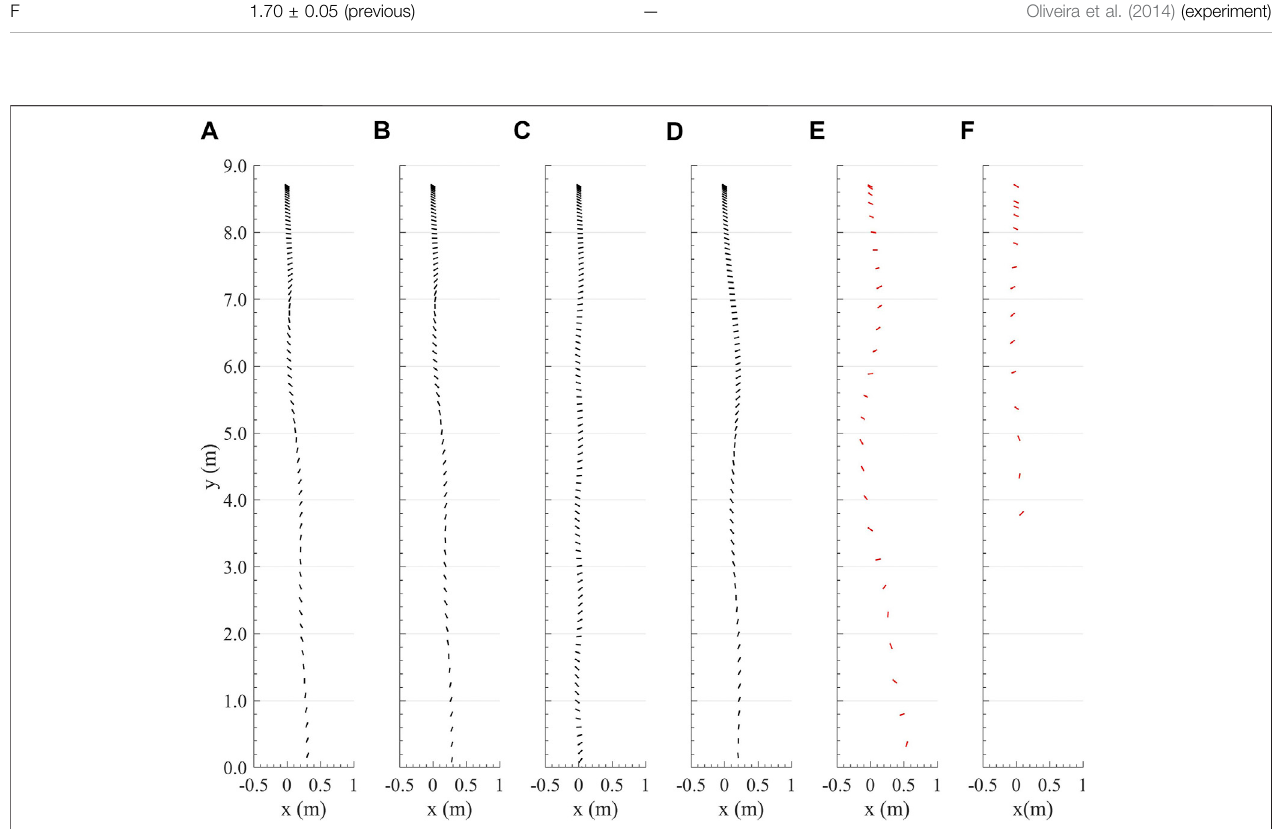
FIGURE 1 | Trajectory of a cylindrical particle released in still air condition in the present simulations using center of pressure formulation of (A) Rayleigh (1876); (B) Marchildon et al. (1964); (C) Rosendahl (2000); (D) Yin et al. (2003); (E) Oliveira et al. (2014); and (F) the experiment of Oliveira et al. (2014).